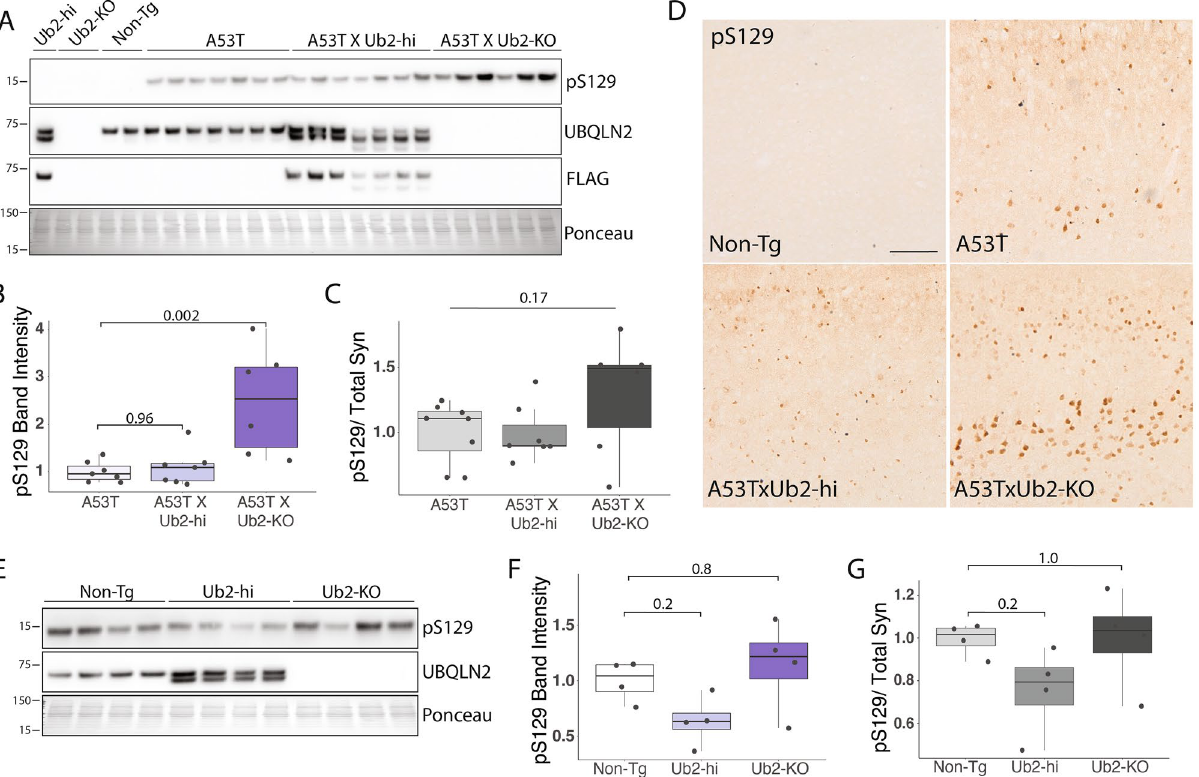
Figure 5. pS129 α-syn accumulates in A53T mice lacking UBQLN2. ( A ) Representative western blot of pS129 in RIPA-soluble brain lysates from the indicated transgenic mouse crosses. ( B ) Quantification from A showing accumulation of pS129 in A53TxUb2-KO mice (n = 6) and unchanged in A53TxUb2-hi mice (n = 7) compared to A53T controls (n = 8). ( C ) Ratio of pS129 to total Syn (see Fig. 4) does not differ significantly between groups (n = 8). ( D ) Representative images of pS129 expression in the cortex of A53T (n = 3), A53TxUb2-hi (n = 3) and A53TxUb2-KO (n = 3) show increased pS129 expression in A53T mice lacking UBQLN2 (12-month-old mice). ( E ) Representative western blots of endogenous pS129 in UBQLN2 transgenic mice. ( F ) Quantification of E showing a trend toward decreased endogenous murine pS129 levels in Ub2-hi mice (n = 4). ( G ) Analysis of the ratio of endogenous pS129 to total endogenous Syn (obtained from Fig. 4) shows no difference between groups (n = 4). Western blots were cropped to focus on protein(s) of interest. Uncropped Western blots are shown in Supplemental Figure